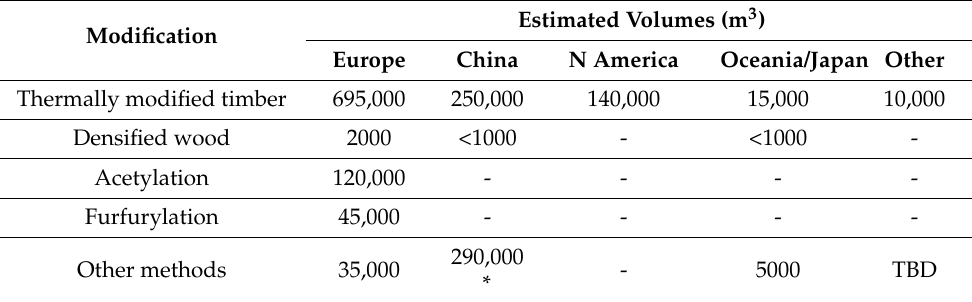
Table 1. Estimated global production of modified wood (Source: